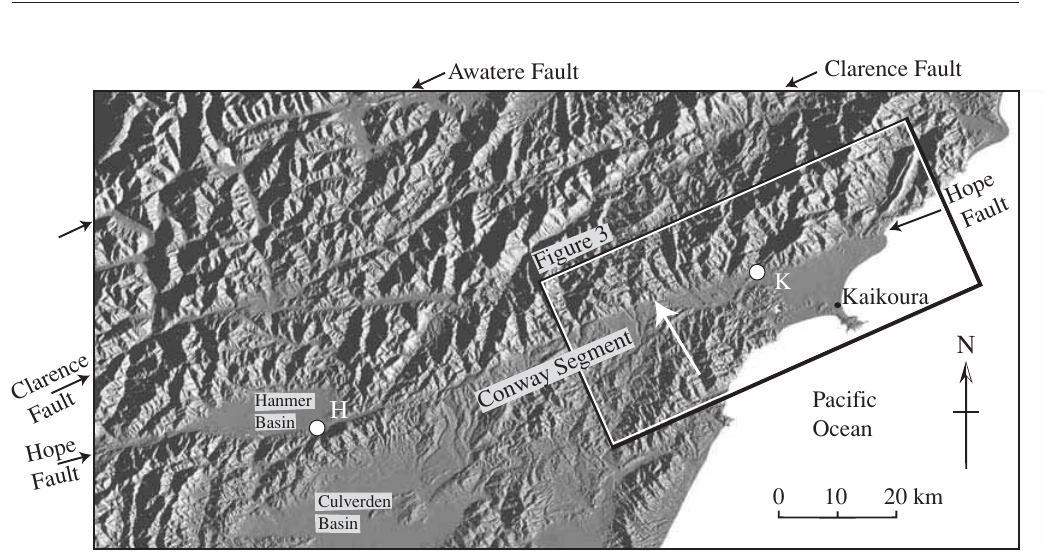
Fig. 2. Digital Terrain Model of the southeast MFZ, illuminated from the southeast. Major active faults are shown by arrows and delineated by the rangefronts and valleys. In the west, the Hope Fault System consists of ENE-trend- ing strike-slip sections separated by the Hanmer Basin extensional stepover, and passes east into oblique-contractional faults near the coast. The Conway Segment is shown between the Hanmer Basin and Kowhai River (K), marked by two white circles. The Greenburn Stream site is shown by a white arrow; Hossack Saddle (H).